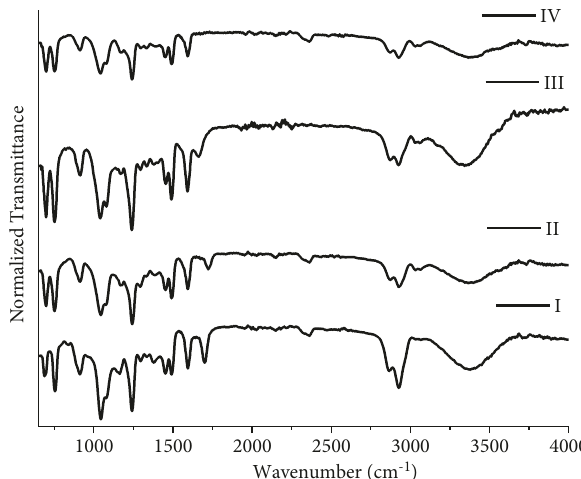
Figure 8: FTIR spectra for groups I, II, III, and IV of green ballpoint pen